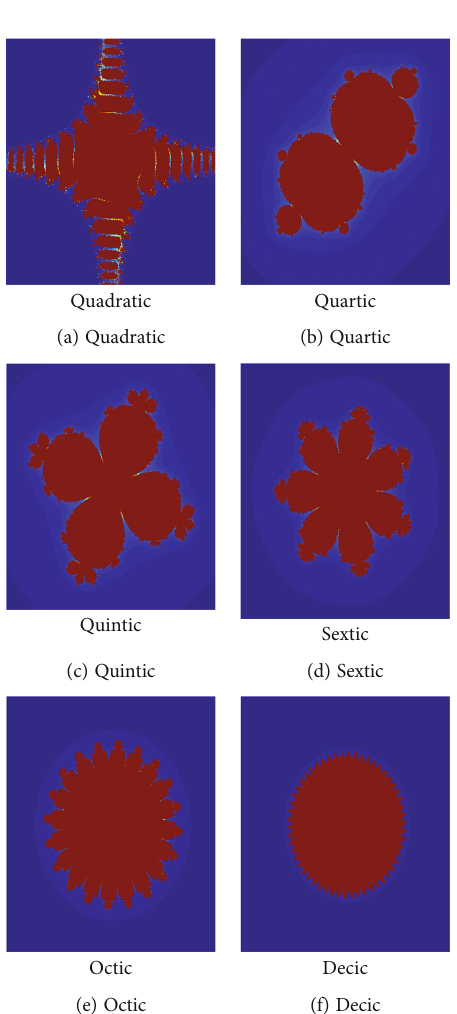
Figure 2: E ff ect of n on Julia